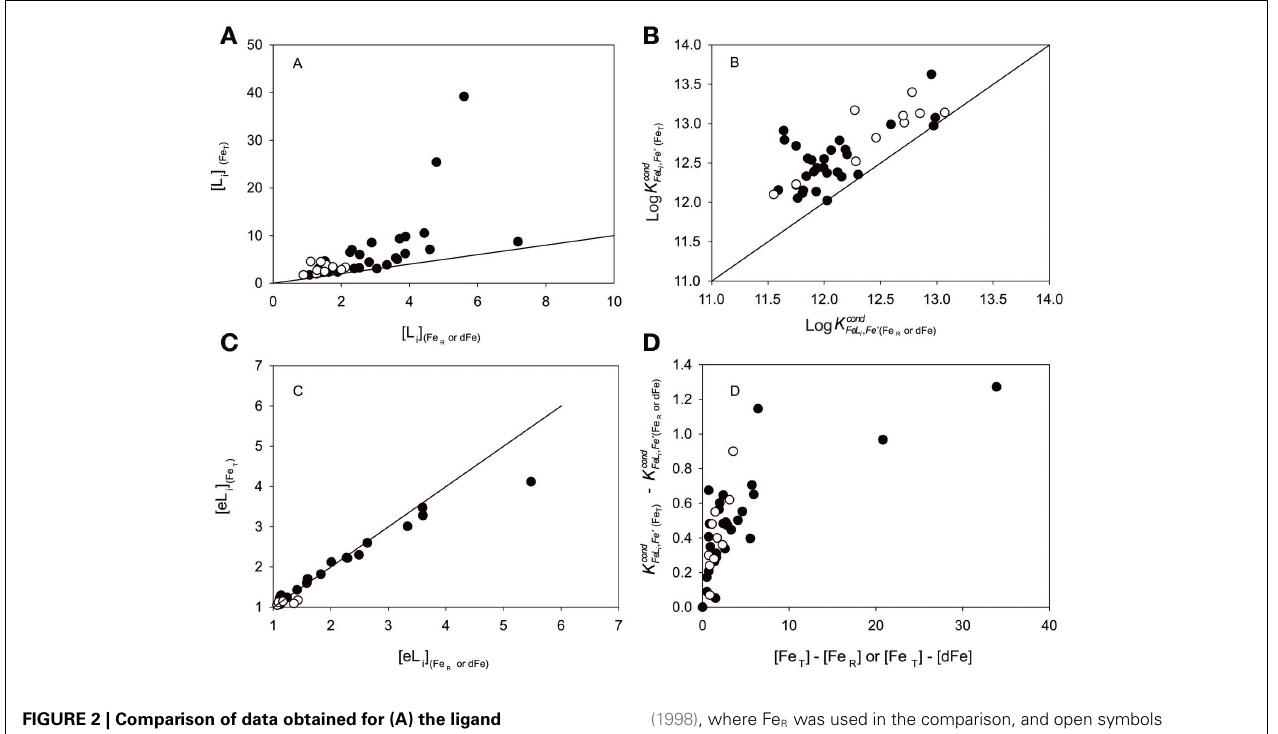
FIGURE 2 | Comparison of data obtained for (A) the ligand concentration [L i ], (B) conditional stability constant log K cond (C) excess ligand concentration [eL i ] determined using either total Fe concentrations or the lower dissolved or reactive Fe concentrations. Closed symbols represent data from Gledhill et al.